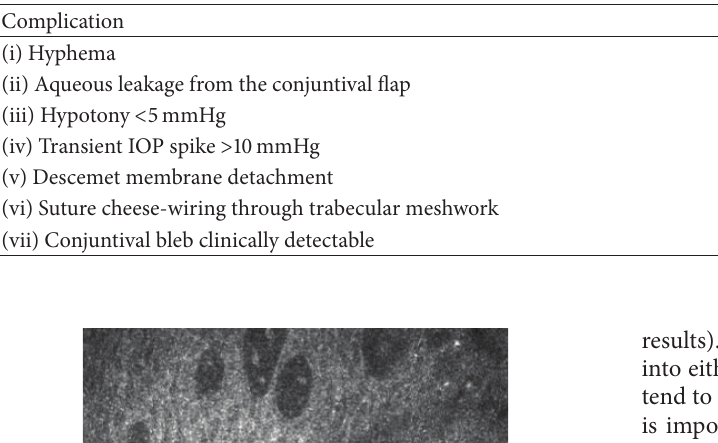
Table 3: Early complications after canaloplasty.